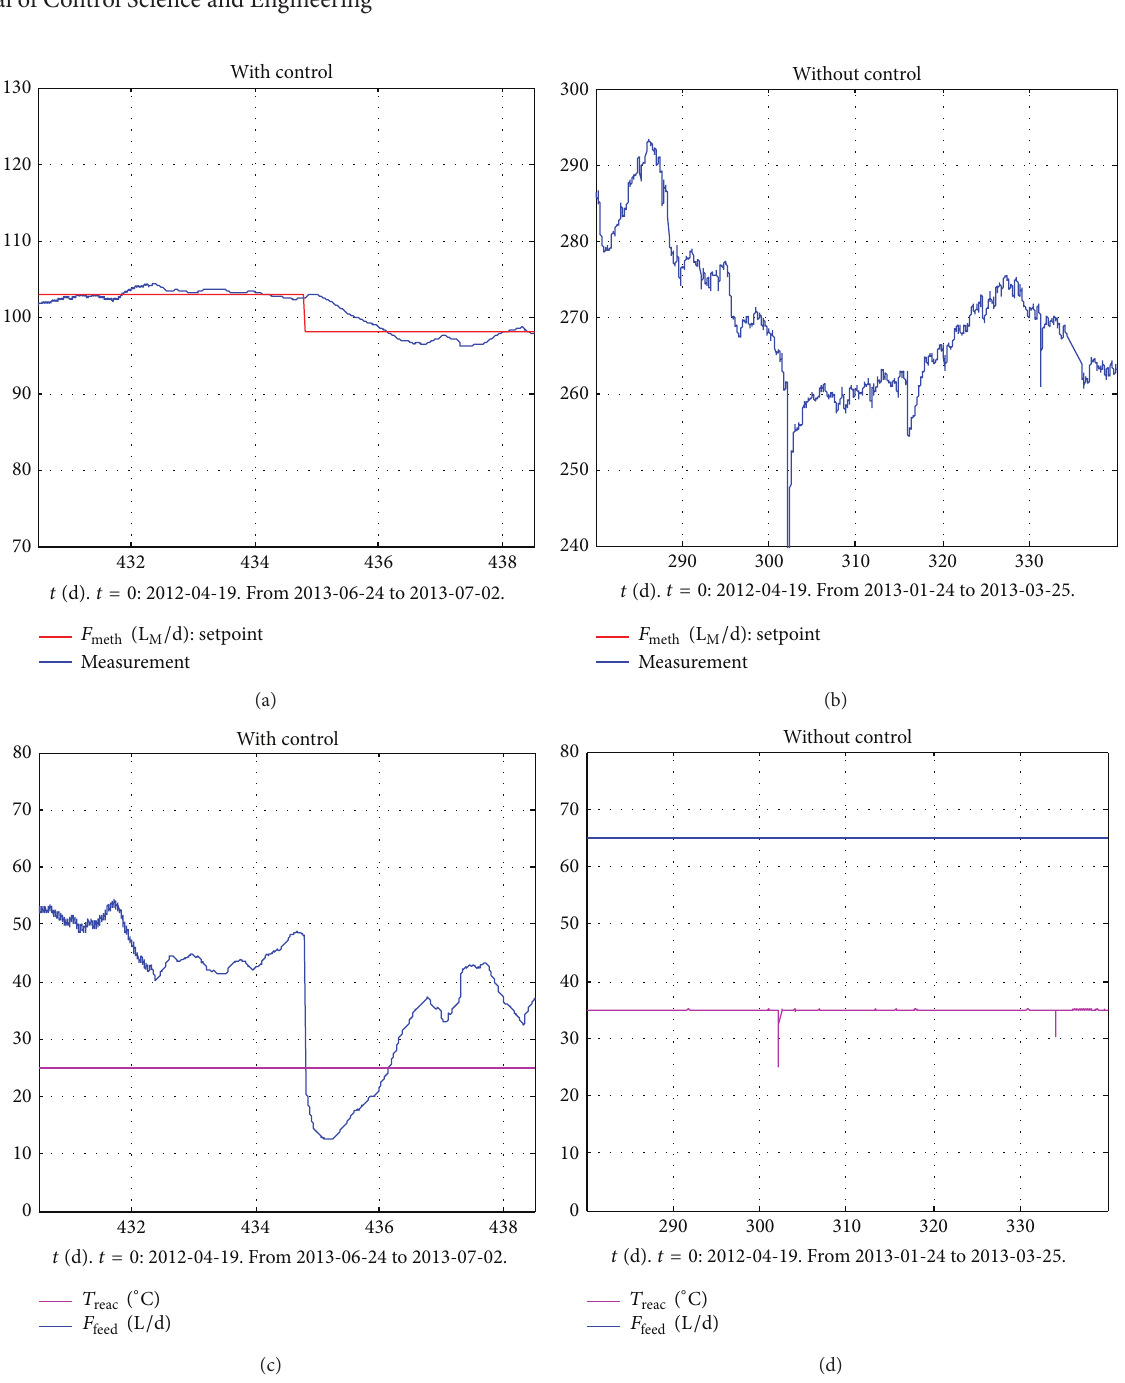
Figure 5: 𝐹 and 𝐹 and 𝑇 , for the real reactor, with (automatic) control and without control. (The length of each of the time intervals meth feed reac for these two cases is different.) (Reprinted from [28] by